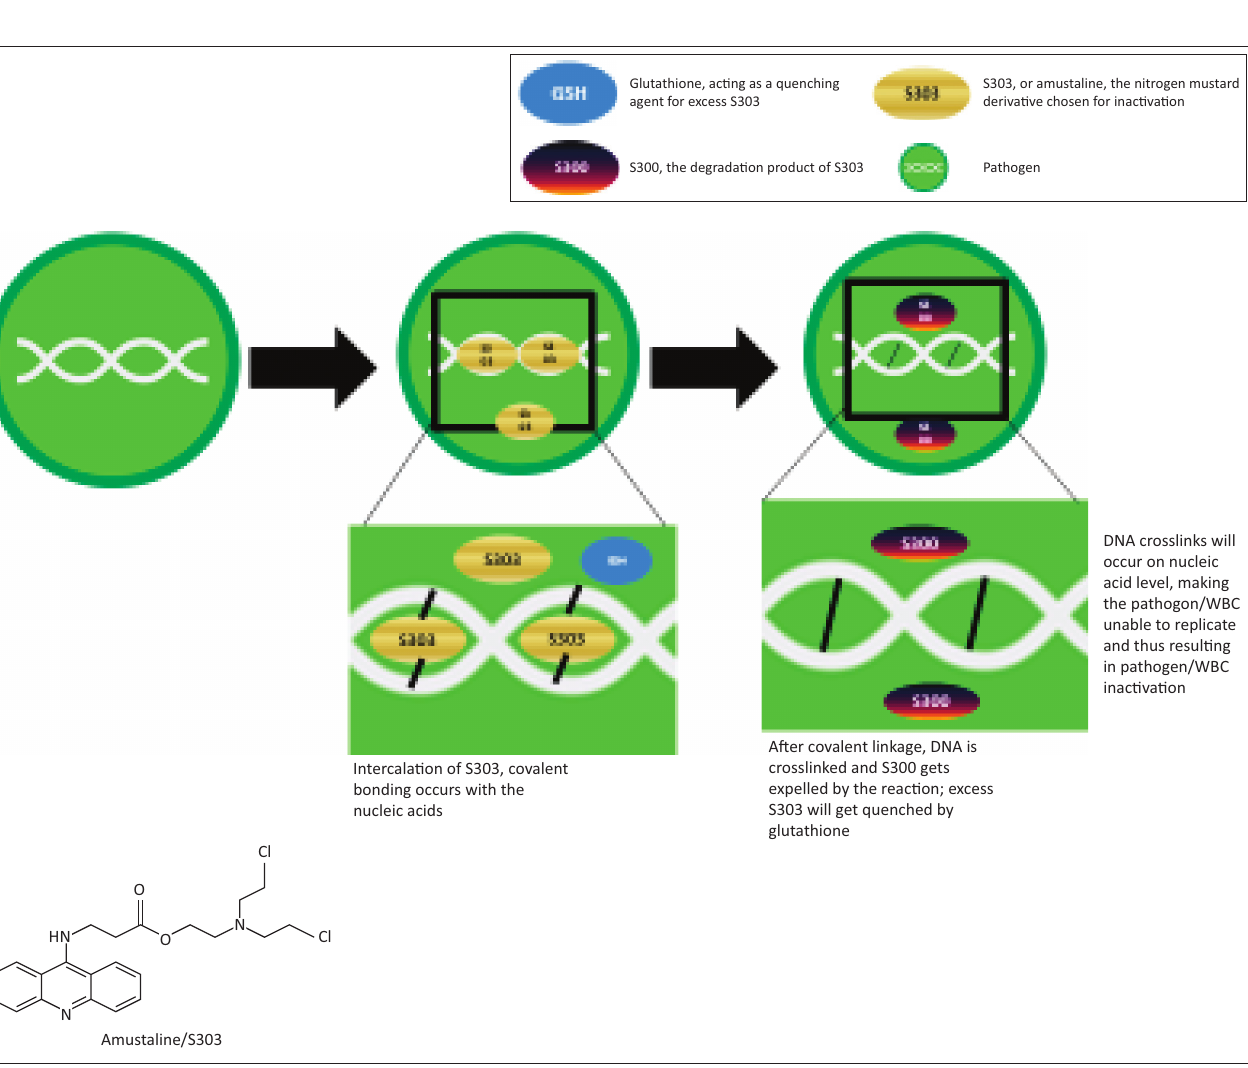
FIGURE 2: Mode of action of the Cerus S-303 system.